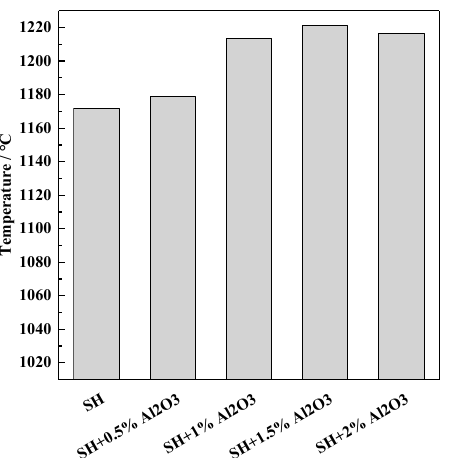
Figure 4. The influence of the addition of Al 2 O 3 on the softening temperature of coal ash.